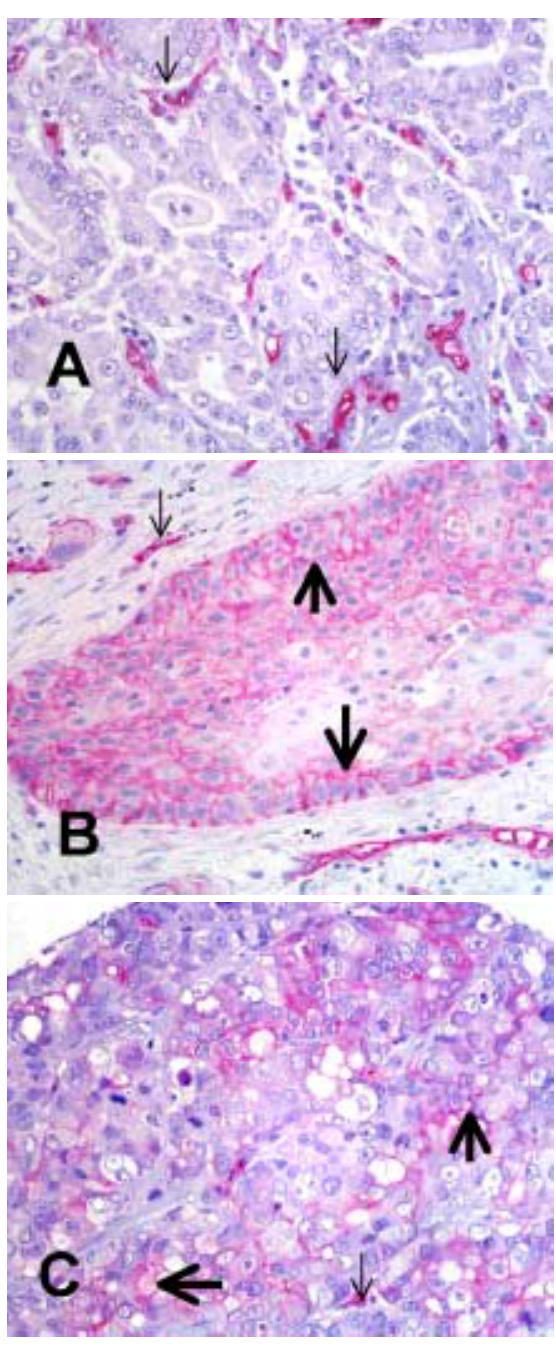
Fig. 1. MCAM immunohistochemistry in NSCLC. Thin arrows hint at the staining of capillaries. Pronounced staining of inter- cellular spaces is marked by thick arrows. (A) Adenocarcinoma without MCAM expression, but with a strong staining of capillar- ies. (B) Squamous cell carcinoma with high MCAM expression. (C) Adenocarcinoma with high MCAM expression. This figure can be viewed on